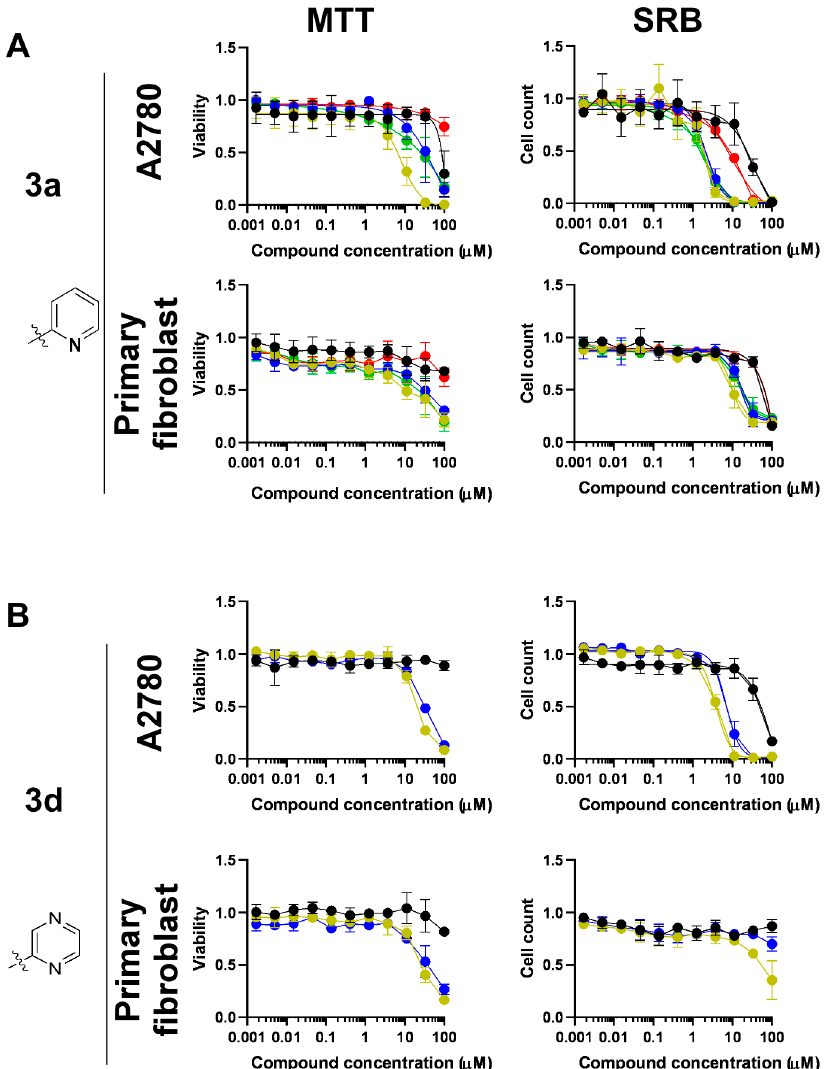
Figure 6. Assessment of the free ligands 3a and 3d and their complexes ( Ru/Os/Ir/Rh-3a and Ru/Os-3d ) for cytotoxic and cytostatic activity (panel ( A ) for compound 3a and its complexes; panel ( B ) for compound 3d and its complexes). For the MTT assays, 3 × 10 3 A2780 cells or 4 × 10 3 primary fibroblasts were plated in 96-well plates. For SRB assays, 1.5 × 10 3 A2780 cells or 2 × 10 3 primary fibroblasts were plated in 96-well plates. Cells were treated with the compounds in the concentrations indicated for either 4 h for the MTT assay or for 48 h for the SRB assay. Data are represented as average ± SD from three biological replicates; individual assays were performed in duplicate. Values